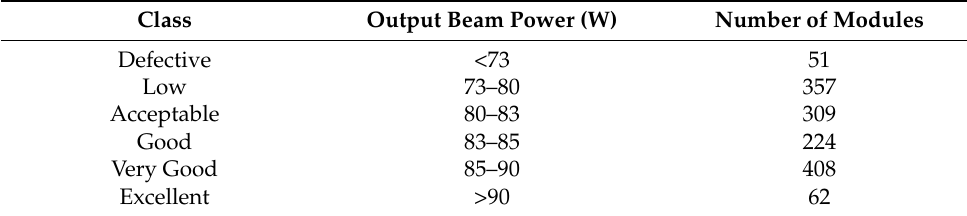
Table 1. Quality classes of the produced modules.